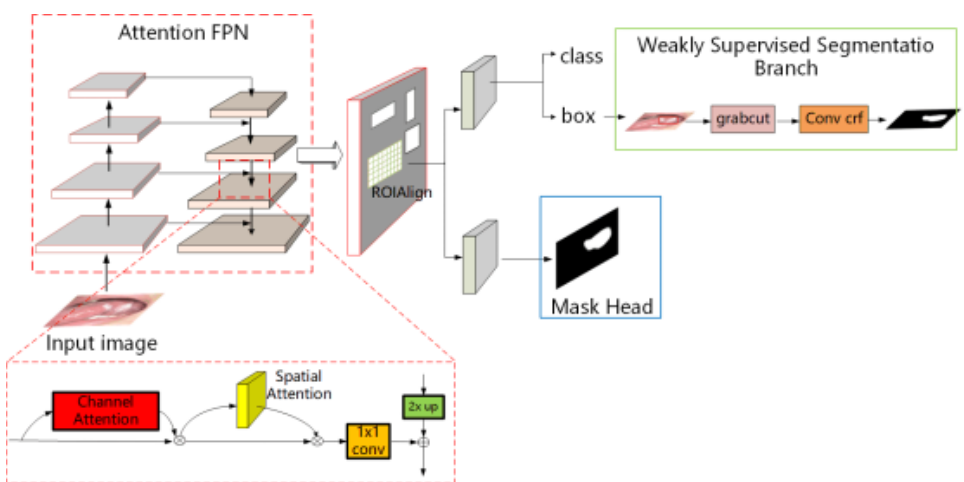
Figure 2. Medical lesion segmentation framework based on dual attention mechanism.